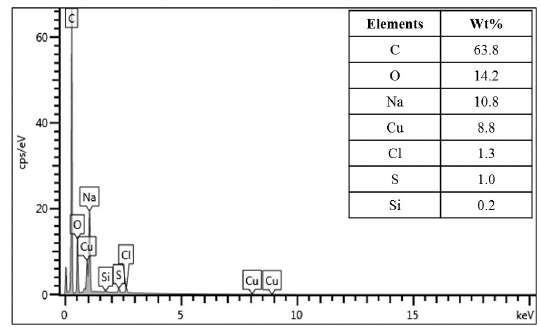
Figure 4. EDS spectrum of the C–Cu